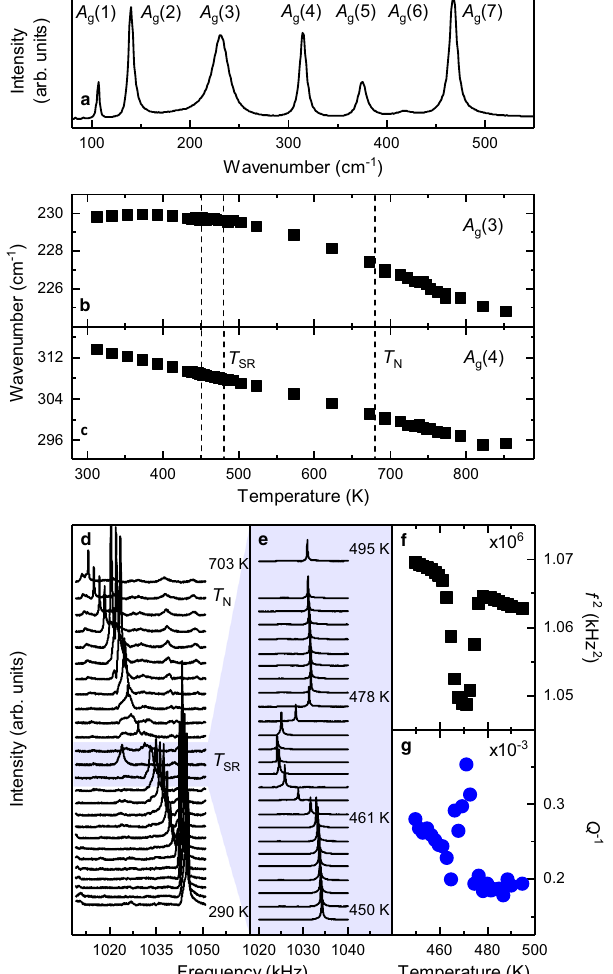
Fig. 2 High-temperature evolution of lattice vibrations and elastic properties. a A g -mode Raman spectrum of SmFeO 3 at room temperature in z(yy)z ̅ con fi guration using Porto ’ s notation 37 (Symbols to the left and right of the parentheses denote the propagation direction, while symbols inside the parentheses indicate polarization of incident and scattered light, respectively.). b , c Evolution of the frequency of A g (3) and A g (4) Raman modes from 300 to 850K, across the spin reorientation T SR and Néel T N temperatures. For the temperature evolution of the complete Raman spectra, the phonon frequencies and FWHM, please refer to Supplementary Note 1 + 2. d Temperature evolution of a representative resonance peak in RUS spectra from room temperature to 700 K, thus above the magnetic ordering (this behavior is alike for all ultrasound resonance bands; see Supplementary Figs. 5 and 6). e Magni fi cation of the RUS spectra across the spin reorientation interval revealing a signi fi cant deviation in elastic moduli. f Evolution of the square of the frequency, f 2 , which scales with some combination of single crystal elastic moduli, showing a softening through the reorientation transition. g The associated acoustic loss data, showing a peak in Q − 1 through the reorientation typical of mobile microstructure. For a further analysis of the elastic anomalies see Supplementary Note